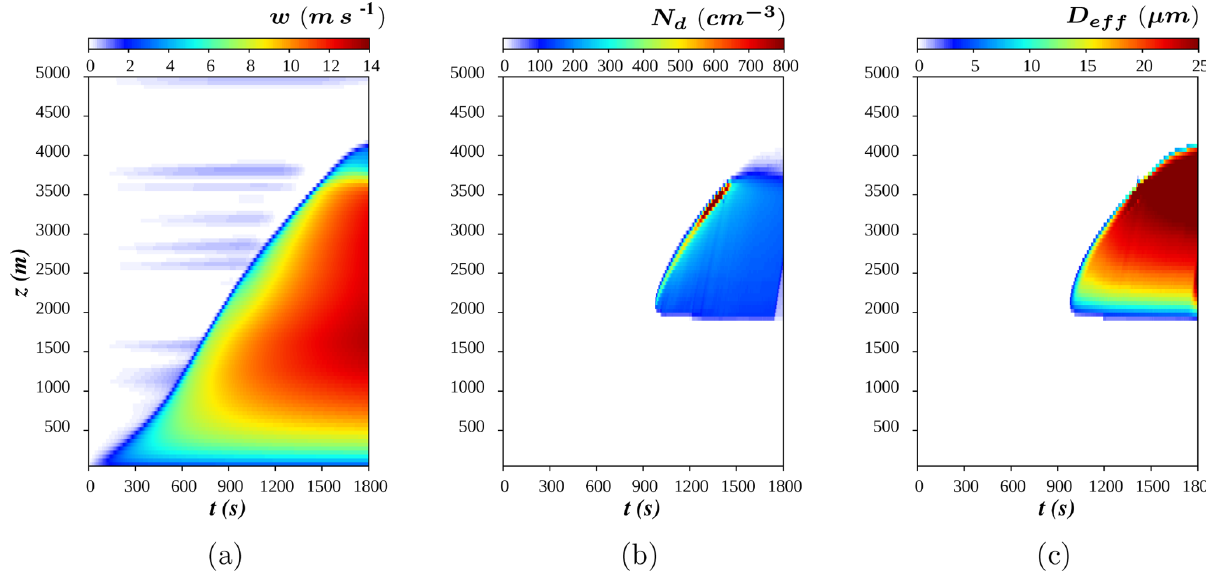
Figure 2. Evolution of w (ms − 1 ), N d (cm − 3 ) and D eff (µm) in the